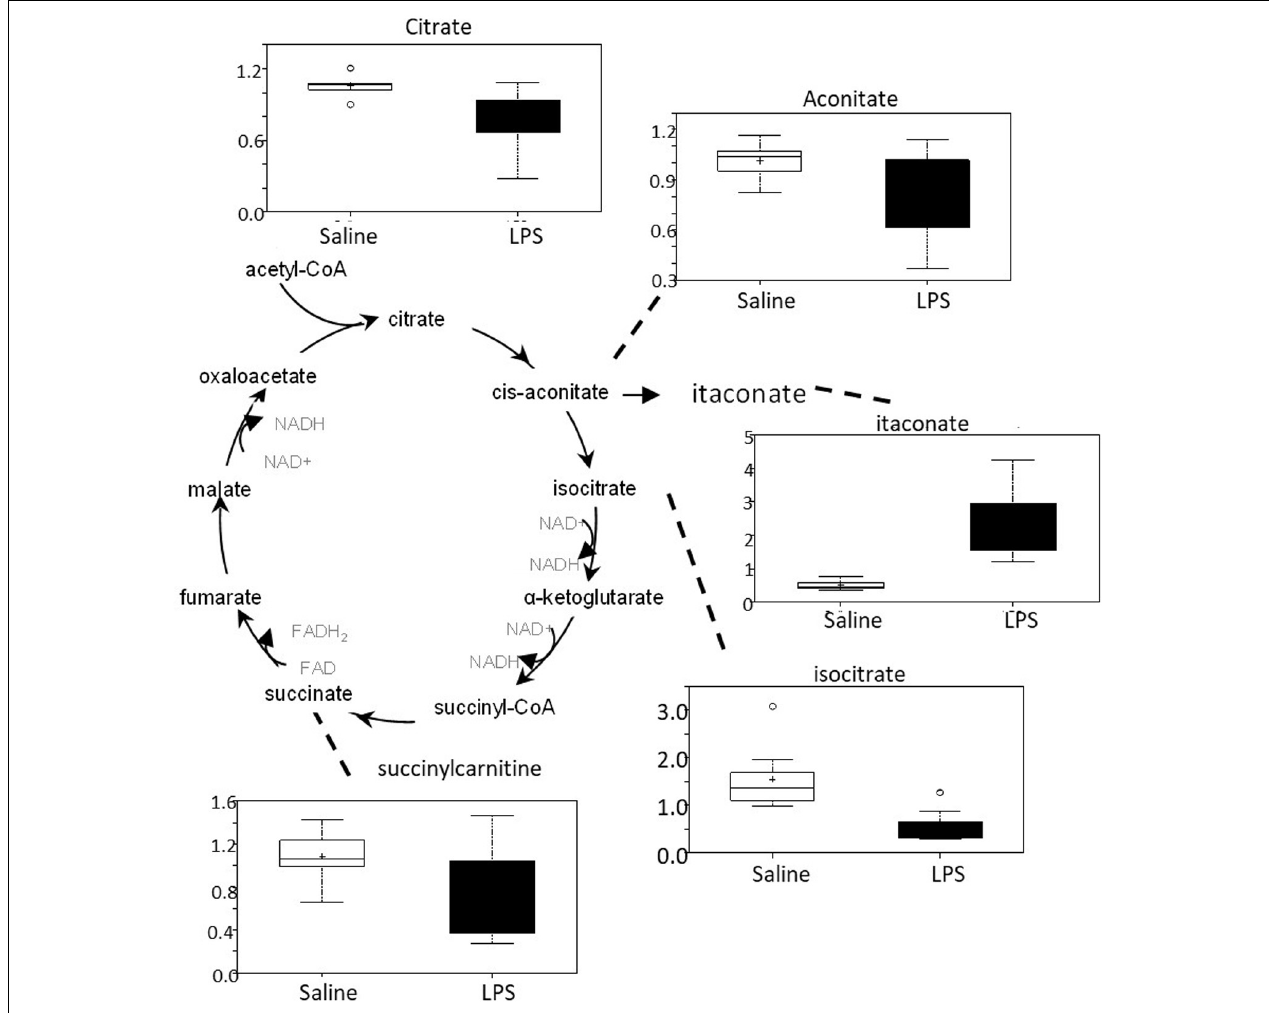
FIGURE 6 | TCA cycle activity is abnormal in LPS placenta. Box plots of TCA cycle metabolites in LPS (black boxes) and control (white boxes). N = 8 both groups.